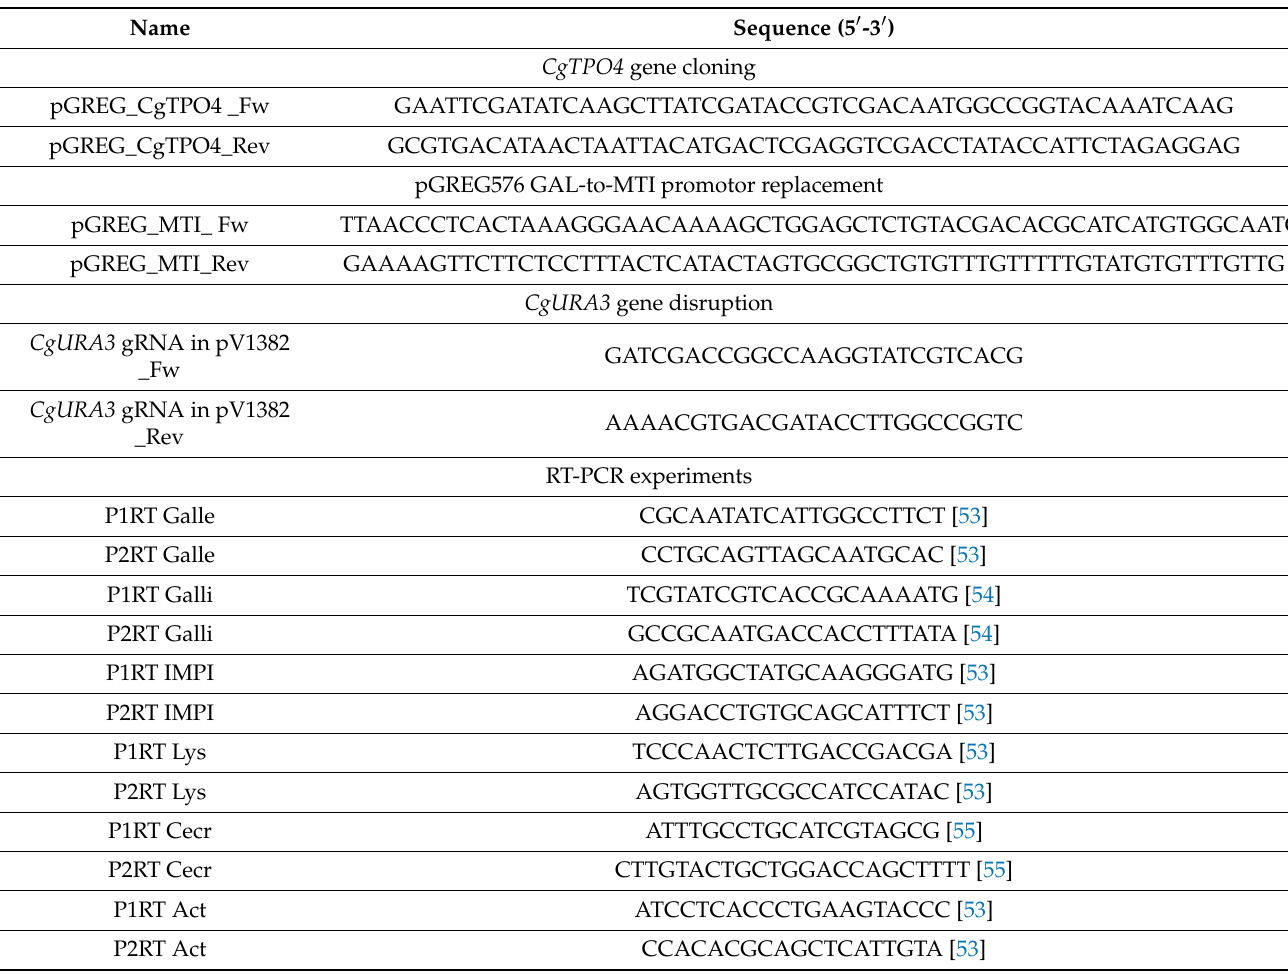
Table 1. List of primers used in this study. Unless otherwise indicated, the primers were generated in this study. Name Sequence (5 (cid:48) -3 (cid:48) ) CgTPO4 gene